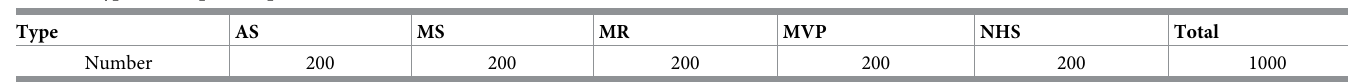
Table 2. Types of samples in open source [25].